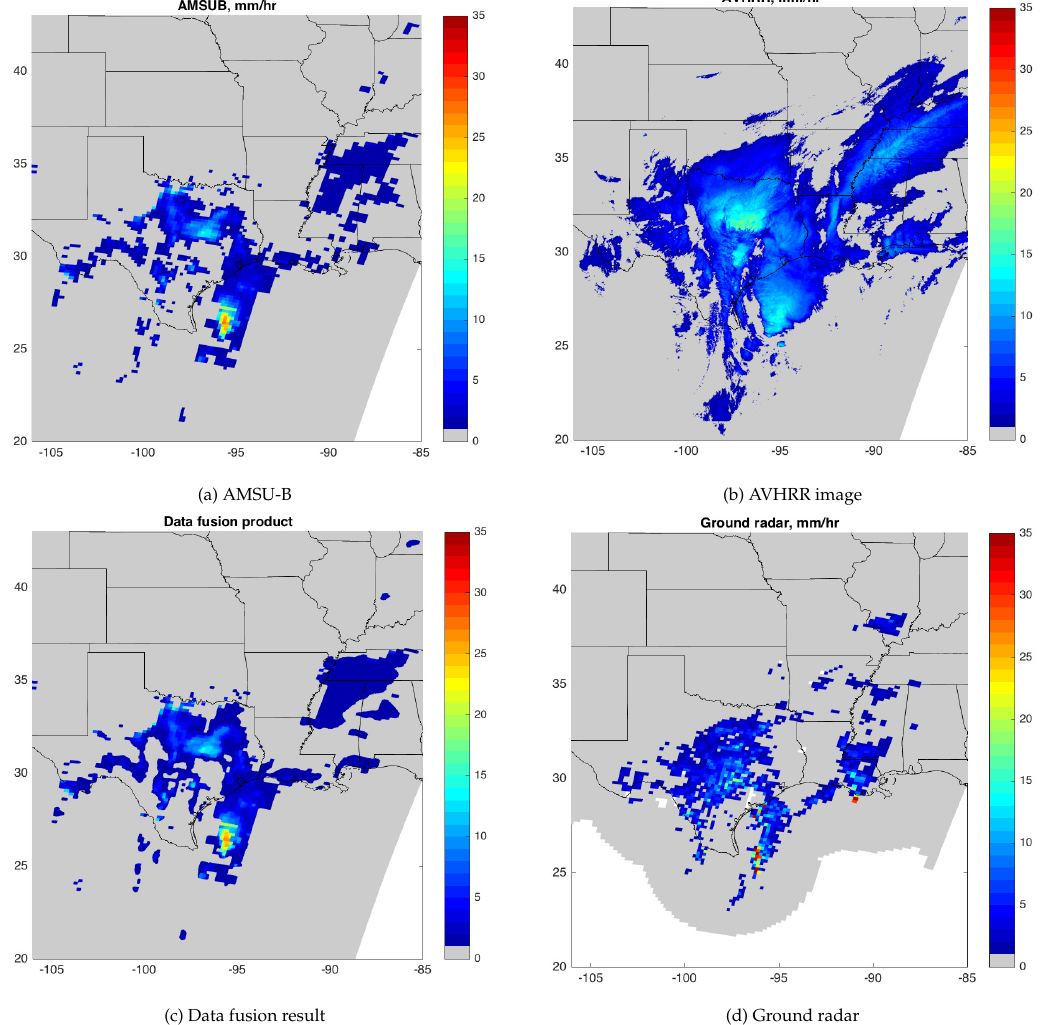
Figure 3. The event on 9 January 2013. ( a ) Rain rate measured from AMSU-B at 15 km resolution. ( b ) Rain rate measured from AVHRR at 1.9 km resolution. ( c ) Fusion product at 1.9 km resolution. ( d ) Instantaneous rain rate measured from ground weather radar.